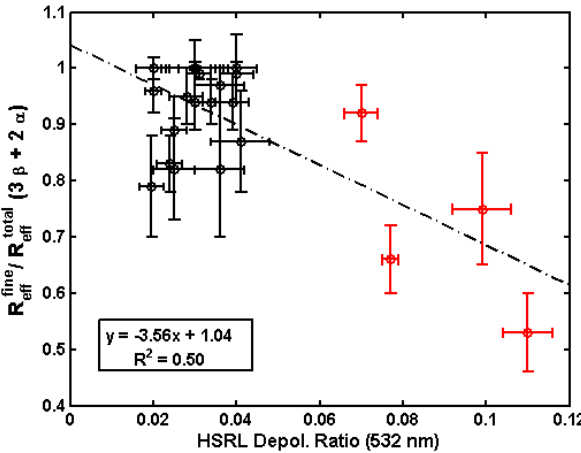
Figure 8. Effective radius fine-to-total mode fraction from lidar retrievals versus total (volume) depolarization ratio at 532nm re- trieved from HSRL-1. All cases and layers are displayed. Red cir- cles represent 22 July